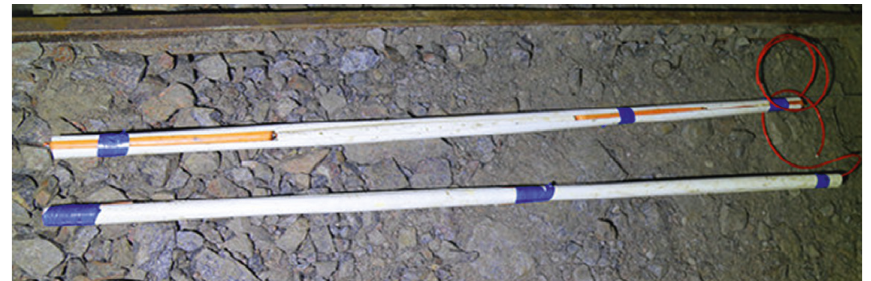
Figure 3: Slit pipe.